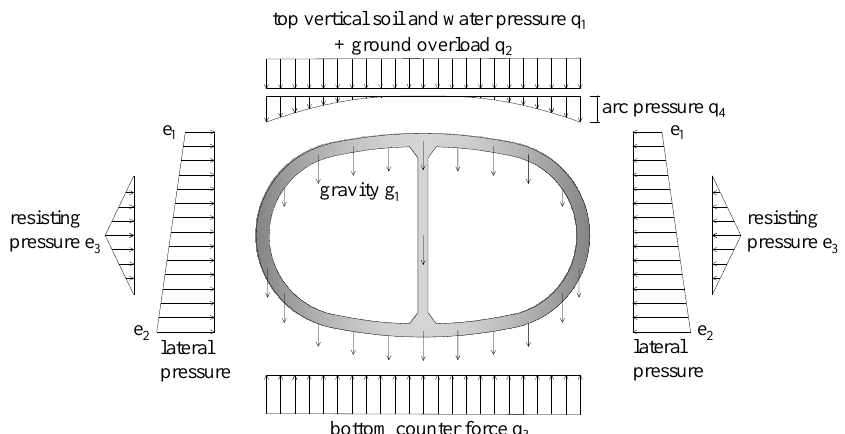
Figure 13. Load distribution for calculation case. Table 5. Parameters for calculation cases.